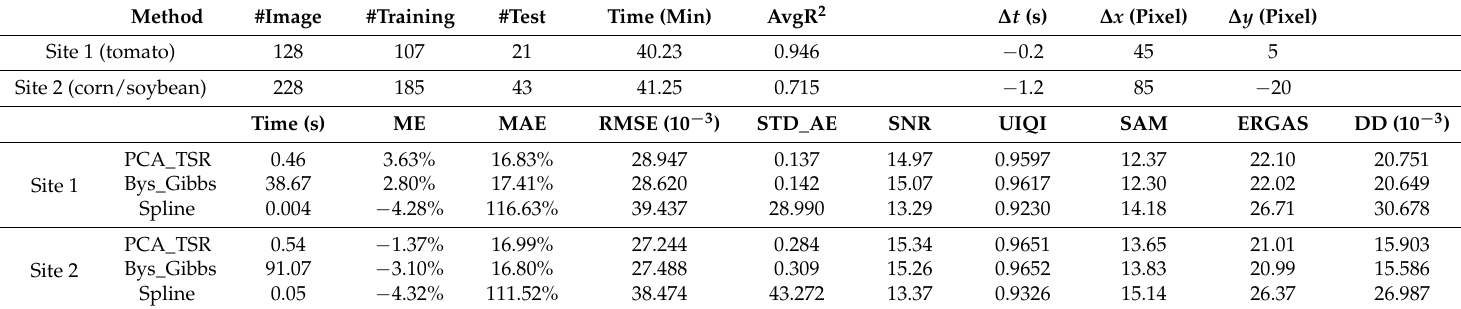
Table 3. Evaluation of hyperspectral data and multispectral image fusion result over the two agriculture